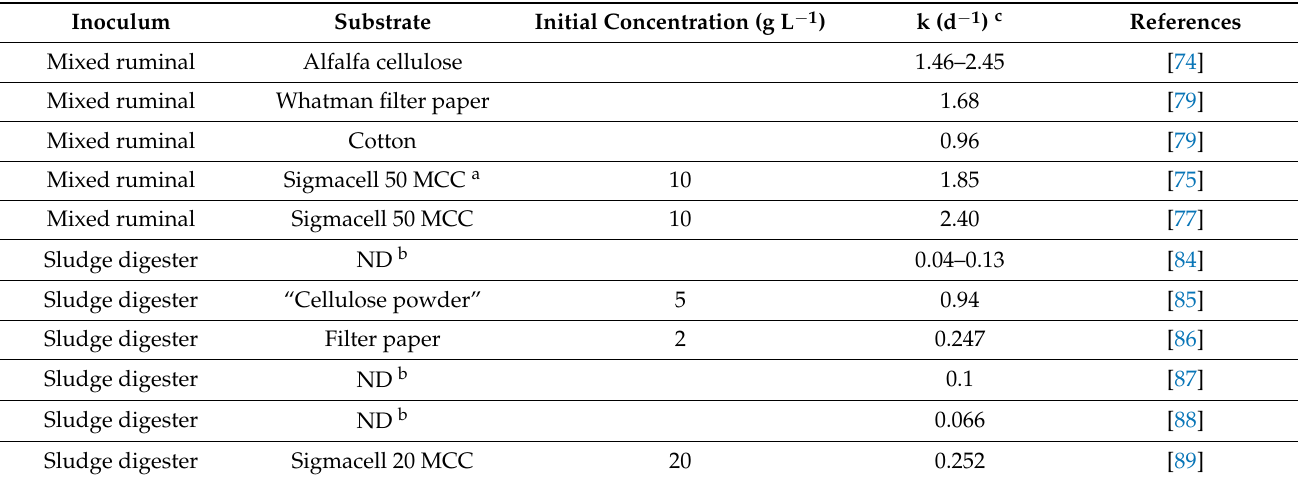
Table 3. First-order rate constants for degradation of cellulose by microbial communities from the rumen and from mesophilic anaerobic